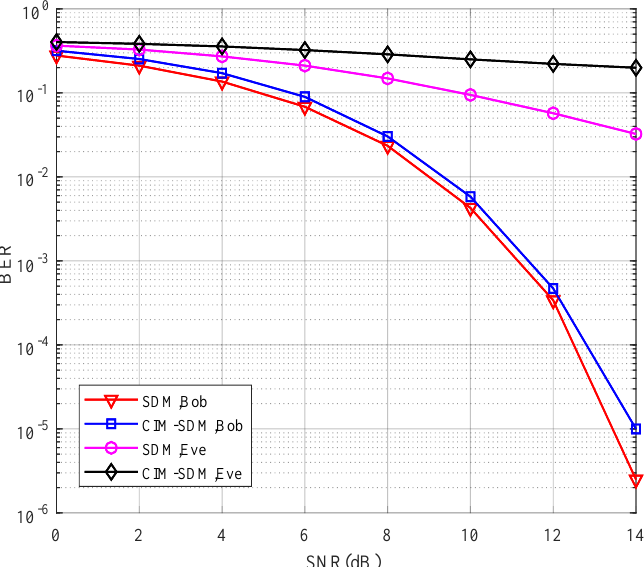
Figure 8. Bob’s and Eve’s BER performances for the proposed CIM-SDM scheme in comparison to the traditional SDM counterparts employing N t = 8, N r = 2, and QPSK.